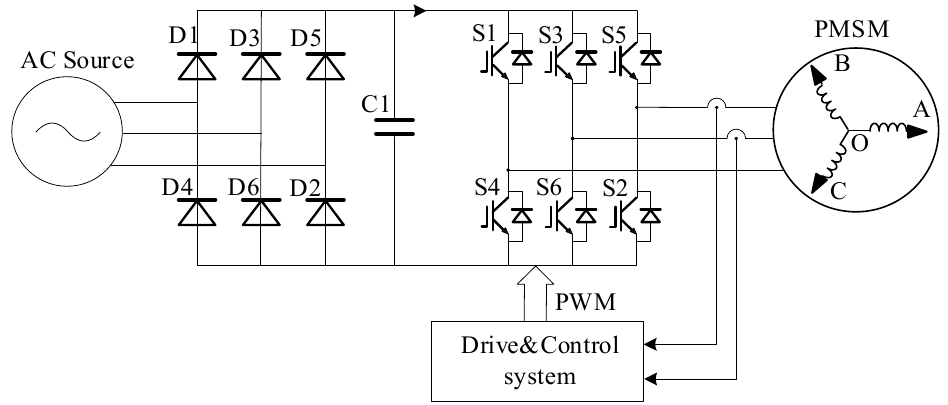
Figure 1. Topology of the PMSM drive system.